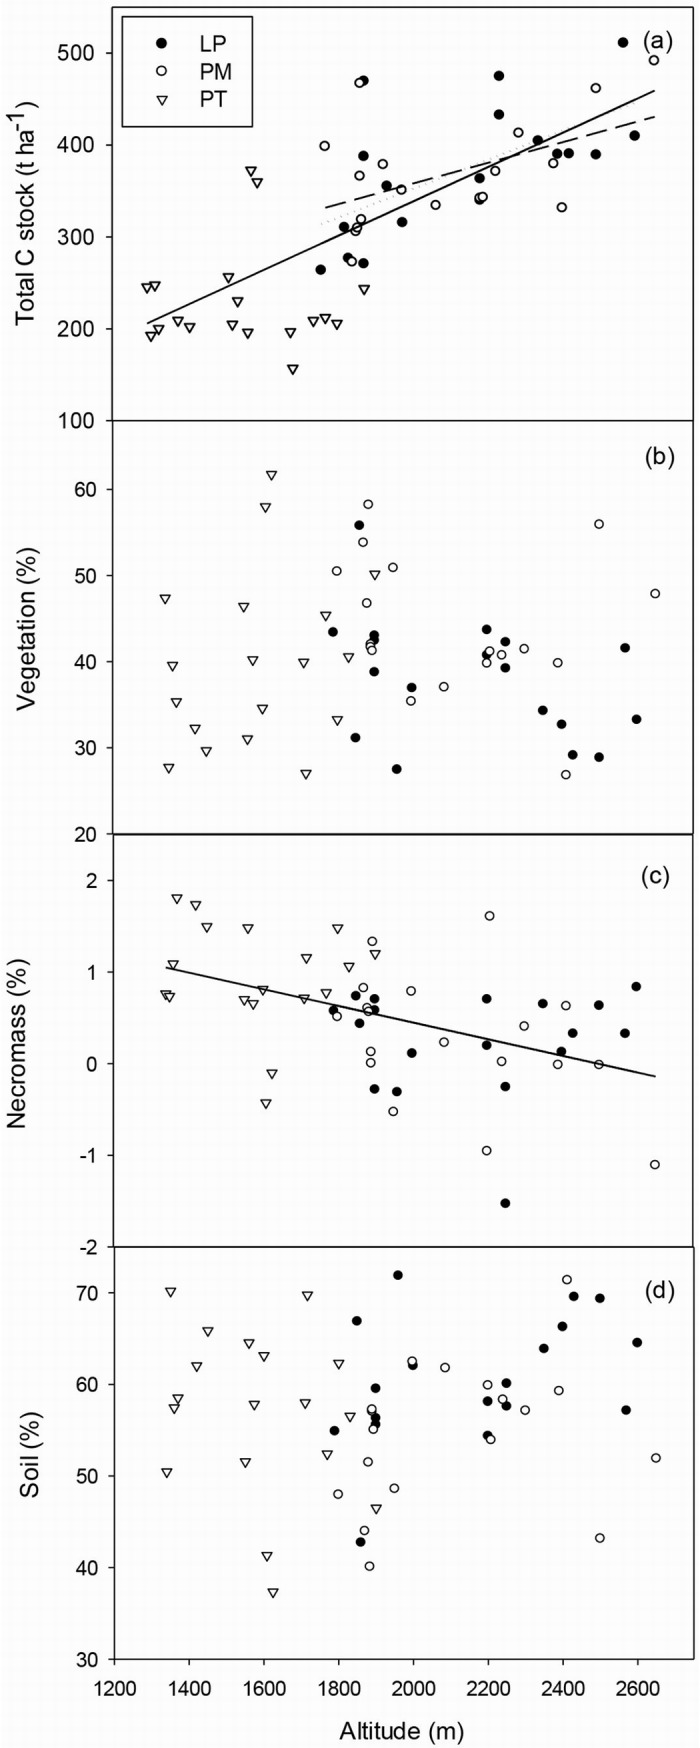
Total C stock (a) and proportions of vegetation (b), necromass (c) and soil C stocks (d) to total C stock along the altitudinal gradient in three coniferous forests on the Loess Plateau, China. LP, Larix principis-rupprechtii forest; PM, Picea meyerii forest; PT, Pinus tabulaeformis forest. The proportion of necromass to total C stock was log-transformed. Solid lines represent significant linear relationships between altitude and total C stock (r2 = 0.56, p<0.001) and the proportion of necromass to total C stock (r2 = 0.22, p<0.001) respectively across the three forests. Dotted and long dash lines represent significant linear relationships between altitude and total C stock within LP forest (r2 = 0.39, p = 0.006) and PM forest (r2 = 0.25, p = 0.033) respectively.